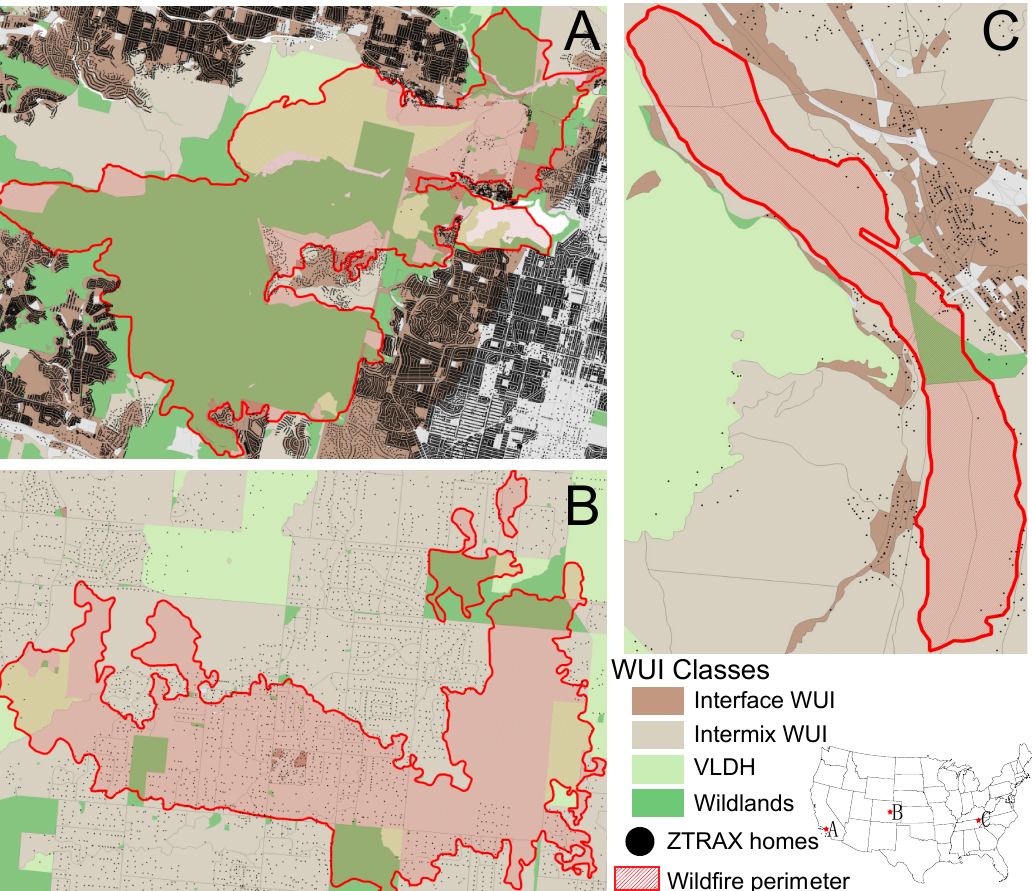
Figure 7. Examples of three wildfires that were human-caused illustrating the enhanced spatial resolution of homes threatened by wildfires using the ZTRAX database compared to the information contained within the census block groups via SILVIS. ( A ) The Topanga wildfire was an urban, human-caused wildfire near Santa Monica, California that started on 28 September 2005. The WUI dataset estimated 7595 homes, while the ZTRAX estimated 936 homes threatened within the fire perimeter. ( B ) The Black Forest wildfire was an arson-caused wildfire in the suburbs of Colorado Springs, CO that started on 11 June 2013. The WUI dataset estimated 1480 homes, while the ZTRAX estimated 859 homes threatened within the fire perimeter. ( C ) A rural, human-caused wildfire from debris burning in northeastern Tennessee that started on 2 March 2006. The WUI dataset estimated 554 homes, while the ZTRAX estimated 54 homes threatened within the fire perimeter.